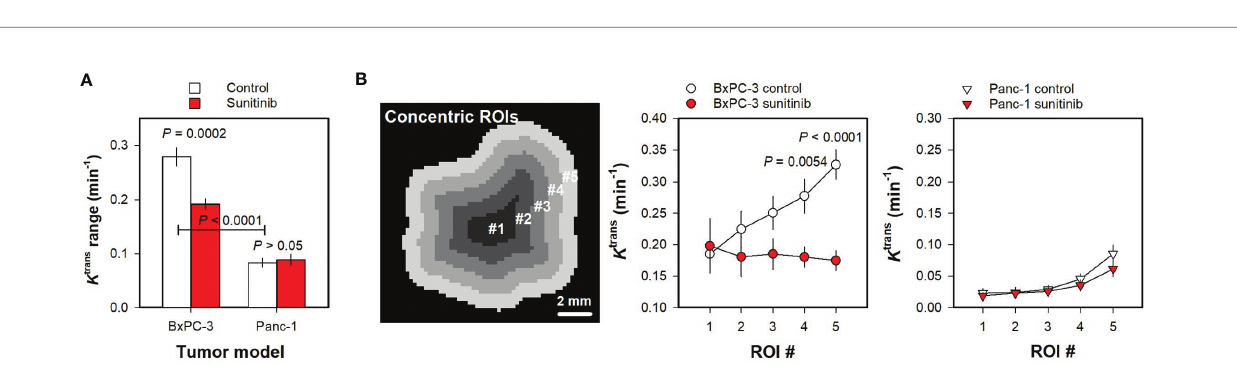
FIGURE 2 | (A) K trans range in untreated and sunitinib-treated BxPC-3 tumors and in untreated and sunitinib-treated Panc-1 tumors. The K trans range represents the difference between the 25 th and the 75 th percentile and was calculated for each tumor. Columns and bars, mean ± SEM of 10-20 tumors. (B) Illustration of fi ve concentric regions of interest (ROI #1-5) in the representative untreated BxPC-3 tumor shown in Figure 1 , and median K trans in concentric ROIs in untreated and sunitinib-treated BxPC-3 tumors and in untreated and sunitinib-treated Panc-1 tumors. The concentric ROIs are bounded by lines drawn at distances of nR/5 from the tumor center, where R is tumor radius and n is ROI number (#1-5). Sunitinib-treated BxPC-3 tumors showed lower K trans values than untreated BxPC-3 tumors in ROI #4 ( P =0.0054) and ROI #5 ( P < 0.0001), whereas the K trans values in the ROIs #1-3 did not differ between the treatment groups ( P > 0.05). Untreated and sunitinib-treated Panc-1 tumors did not differ in K trans in any of the concentric ROIs (ROIs #1-5: P > 0.05). Points and bars, mean ± SEM of 10-20